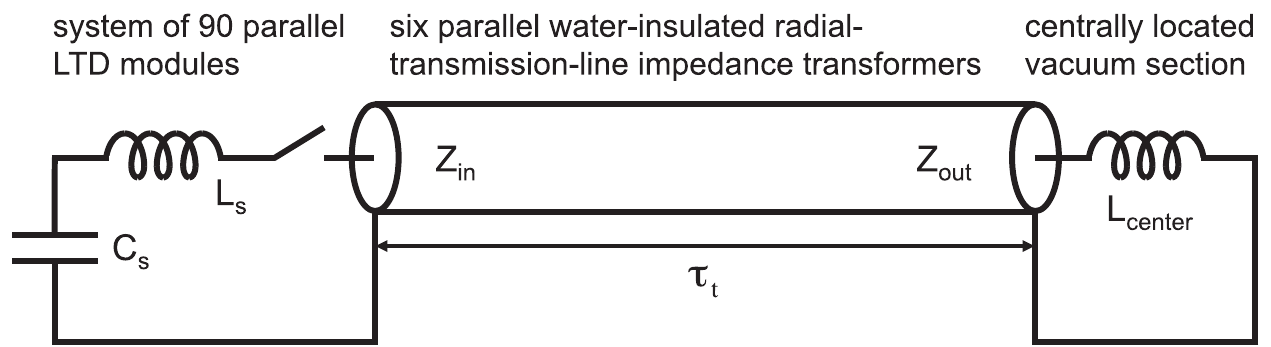
FIG. 15. Idealized version of the accelerator-circuit model illustrated by Fig.